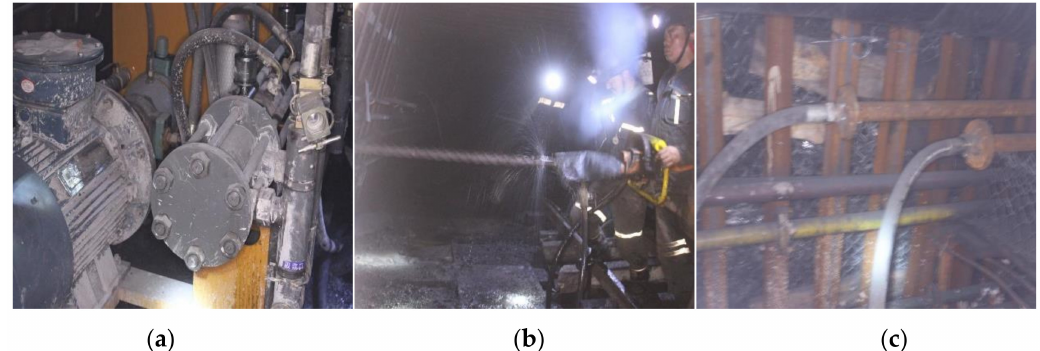
Figure 13. Field grouting equipment: ( a ) Grouting pump; ( b ) Wind coal drill; and ( c ) Grouting pipe.